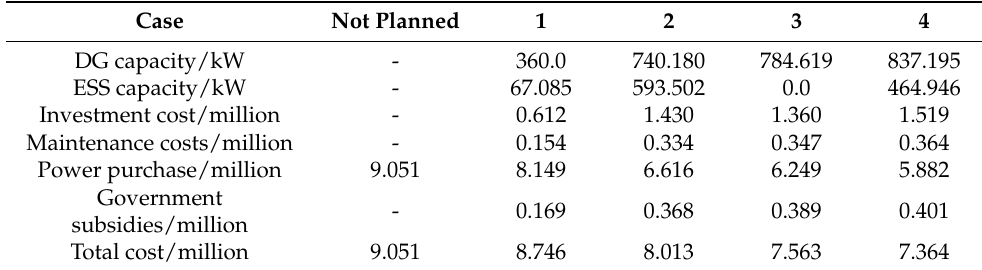
Figure 9. The upper level plans the capacity of each partition of the DPG and ESS. Table 2. Capacity and cost of the upper-level DPG and ESS.